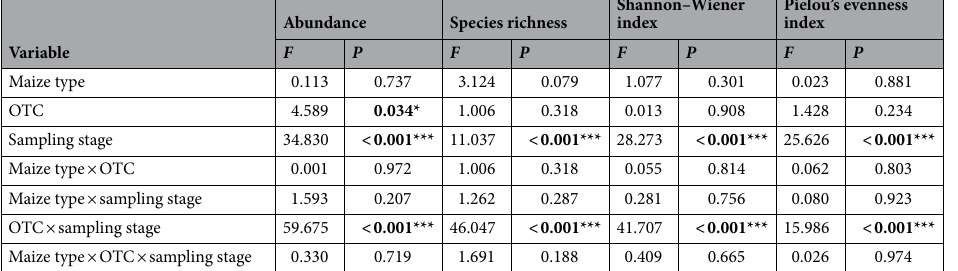
Table 2. Effects of the maize type, open-top chambers (OTC), and sampling stage on the soil collembolan abundance, and diversity indices at different sampling stages, as analyzed using three-way analysis of variance (ANOVA). The values highlighted in bold are statistically significant (* P < 0.05; *** P <